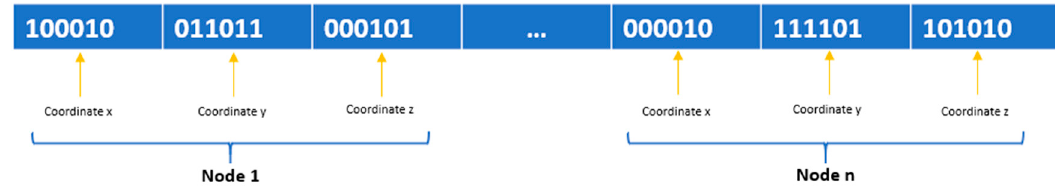
Figure 4. Binary coding in GA. Example of association between Cartesian node coordinates and their value in binary coding.